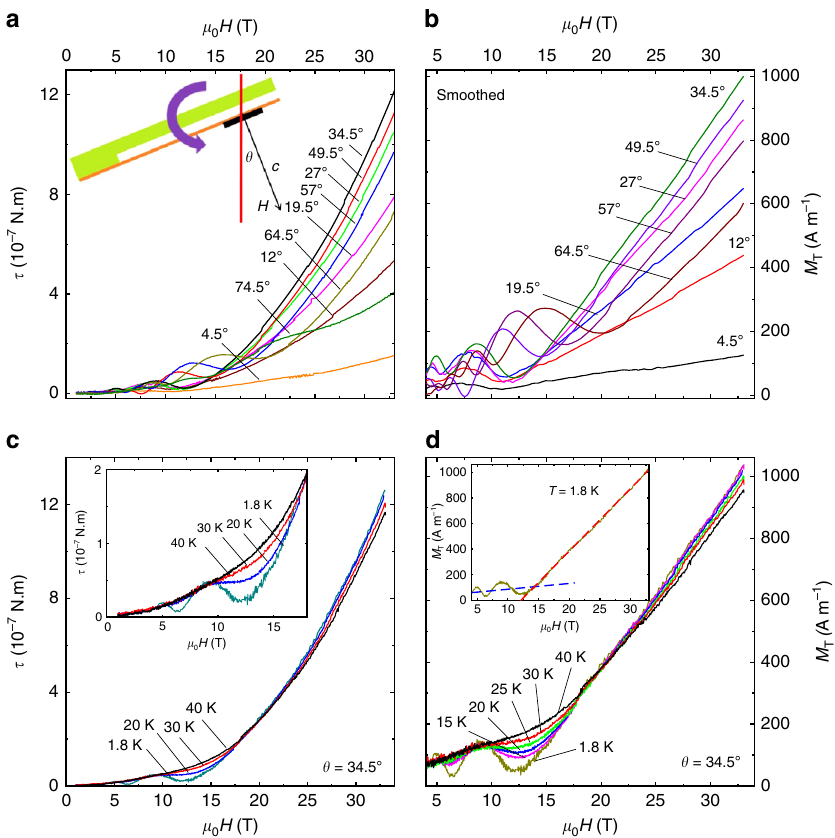
Fig. 2 τ and M T versus magnetic fi eld at different temperatures and angles. a, b τ and M T at 1.8 K at different tilted angles, respectively. Inset in a shows the rotation setup where the angle θ is de fi ned as the tilt off the c -axis. The curves in b have been smoothed. c, d τ and M T in a fi xed angle ( θ = 34.5°) at different temperatures, respectively. Inset in c shows a zoom-in in low fi elds where strong temperature dependent dHvA QOs superpose on a parabolic background. Inset in d shows the M T curve at 1.8 K, where two dashed coloured lines show the low- and high- fi eld slopes. The slope takes an obvious enhancement near the